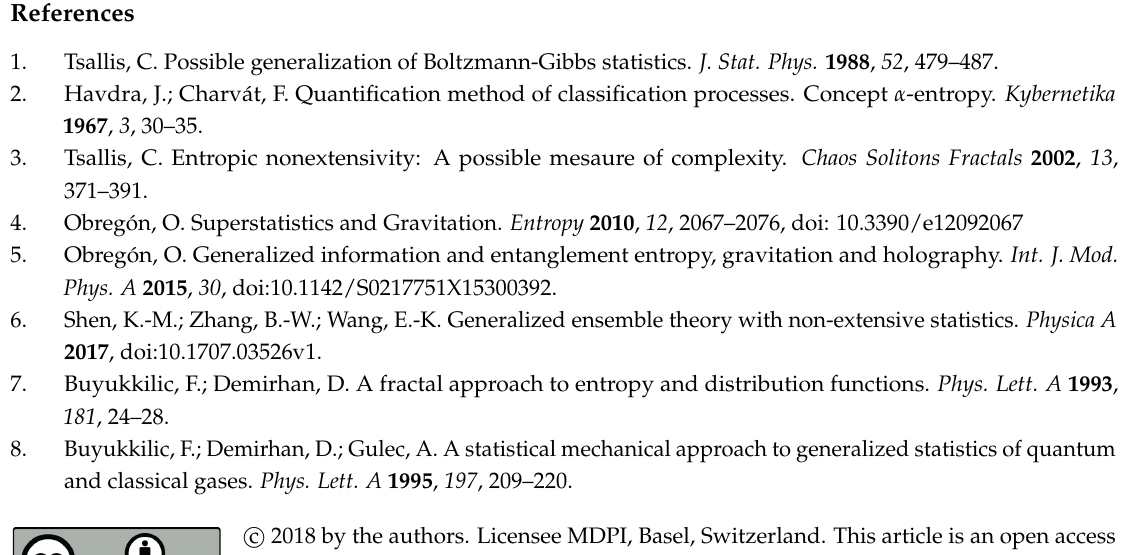
( β E ) . The red line ), and classical p l = e − β E l with g l II II ( β E ) , brown line to classical l II